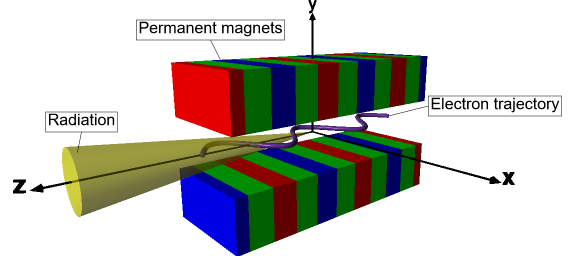
FIG. 1. Chosen coordinate system for the description of undulator (wiggler)